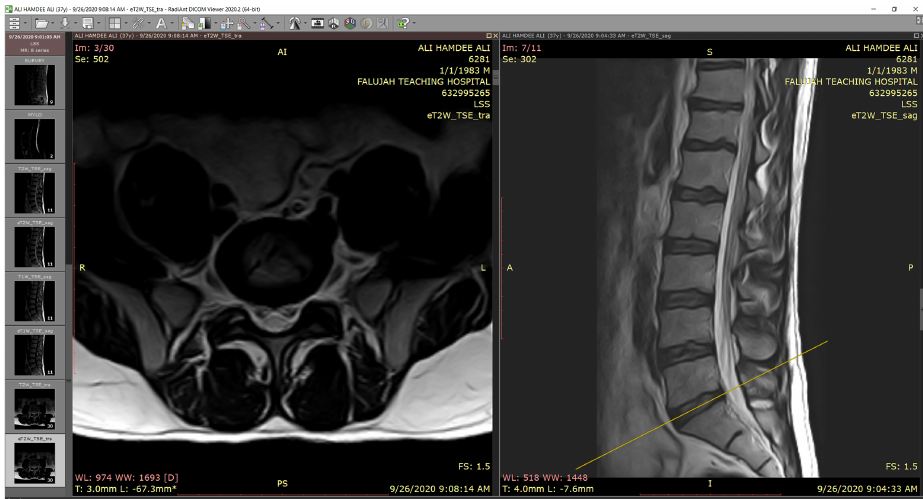
Figure 2. RadiAnt DICOM viewer.